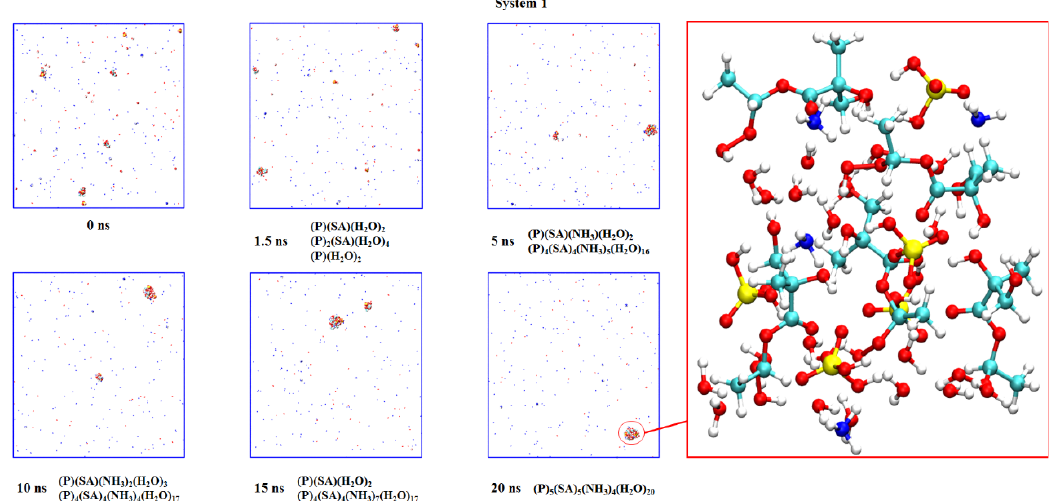
Figure 6. The snapshots of nucleation simulation for the reaction product of anti -CH 3 CHOO + MGA-COOH.